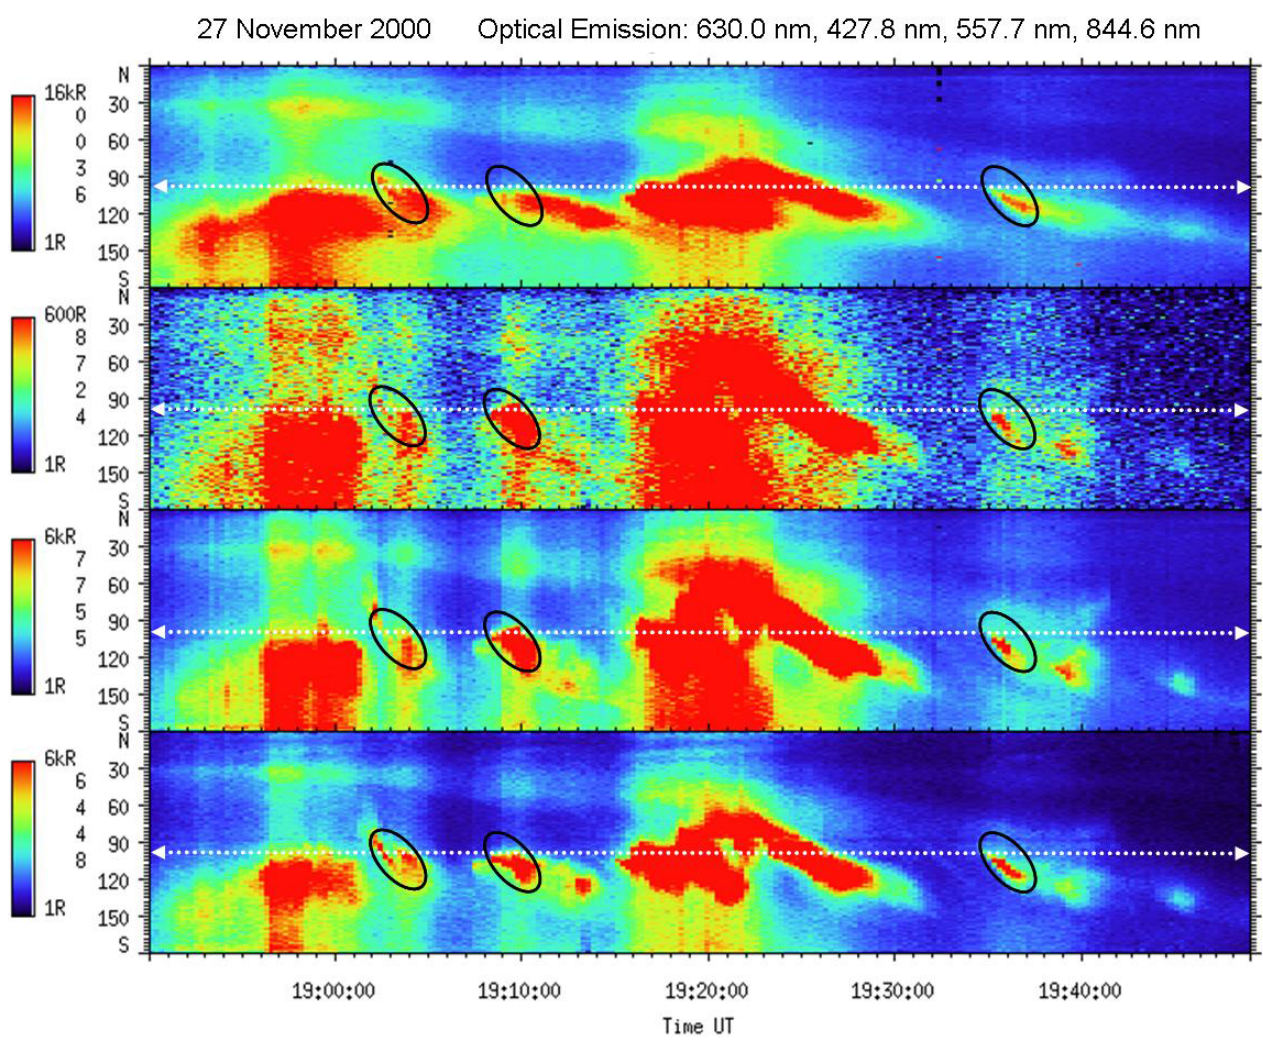
Fig. 4. An overview of the recorded emission intensity by the MSP in Rayleigh versus time and scan angle for the 630.0nm, 427.8nm, 557.7nm and 844.6nm lines. The white dashed line represents the intersection with the radar field of view. The black ovals encapsulate 3 small and distinct separated